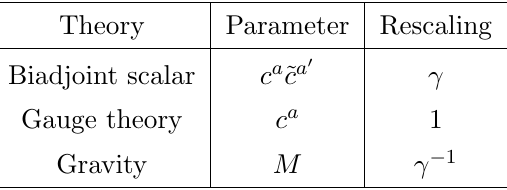
Table 1 . Di(cid:11)erent scalings needed for the source parameters in di(cid:11)erent theories, where the factor in the third column multiplies the parameter in